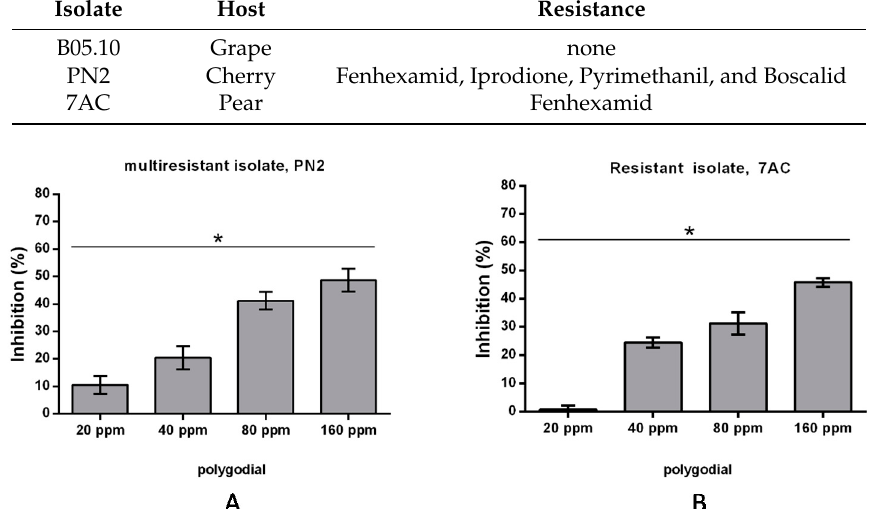
Figure 3. Effect of polygodial on mycelial growth of native B. cinerea with different degrees of sensitivity to commercial fungicides. Percentage of growth inhibition determined after 48 h of incubation at different concentrations of polygodial, i.e., 20, 40, 80 and 160 ppm against: ( A ) multiresistant (PN2); and ( B ) resistant (7AC) B. cinerea isolates. Each bar represents the average of at least three independent experiments ± standard deviation. (*) denotes significant differences between all polygodial concentrations evaluated by Tukey’s test; p < 0.05.